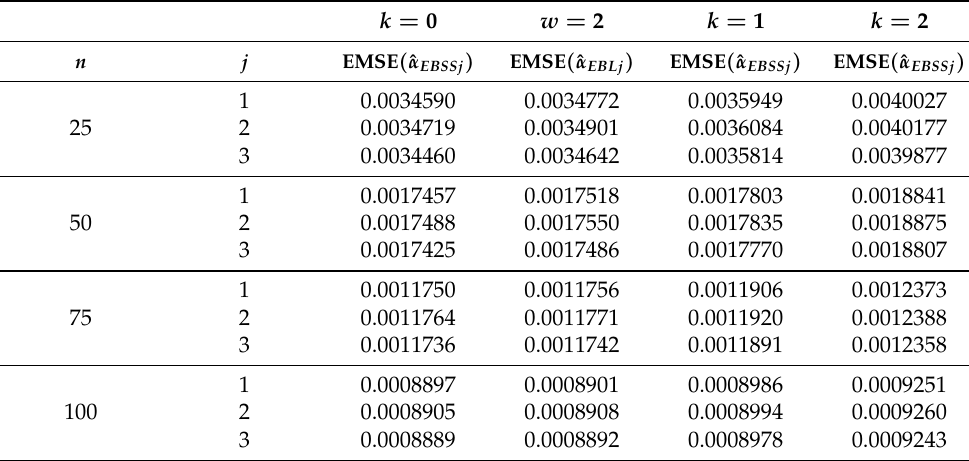
Figure 2. The flowchart for using the proposed E-Bayesian estimation methods in Section 5. Table 1. Simulated EMSE of ˆ α with s = 0.9, β = 3, u = 4 and v =